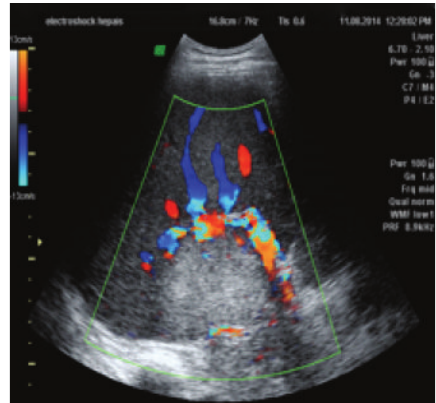
Figure4: ColorDoppler showsnosignsof vascularization centrally, with only slight signs of vascularization around periphery.